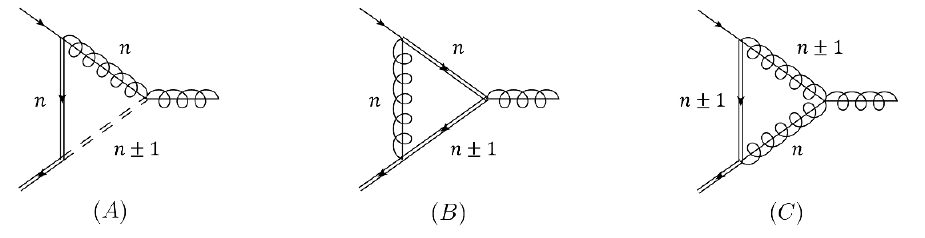
Figure 4 . Sample diagrams for the KK-contributions to the vertex with two level-1 modes as external